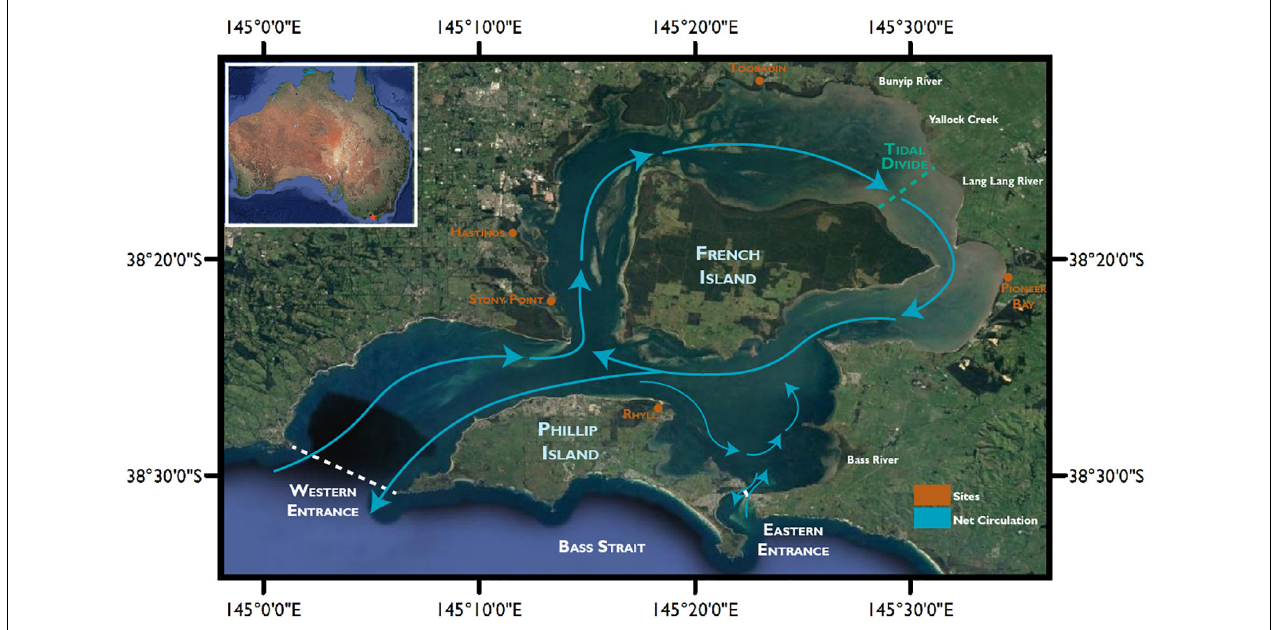
FIGURE 1 | Location of data collection sites, features and net water circulation around Western Port Bay. Net circulation patterns based on Harris et al. (1979). Map data: Google, Maxar Technologies.